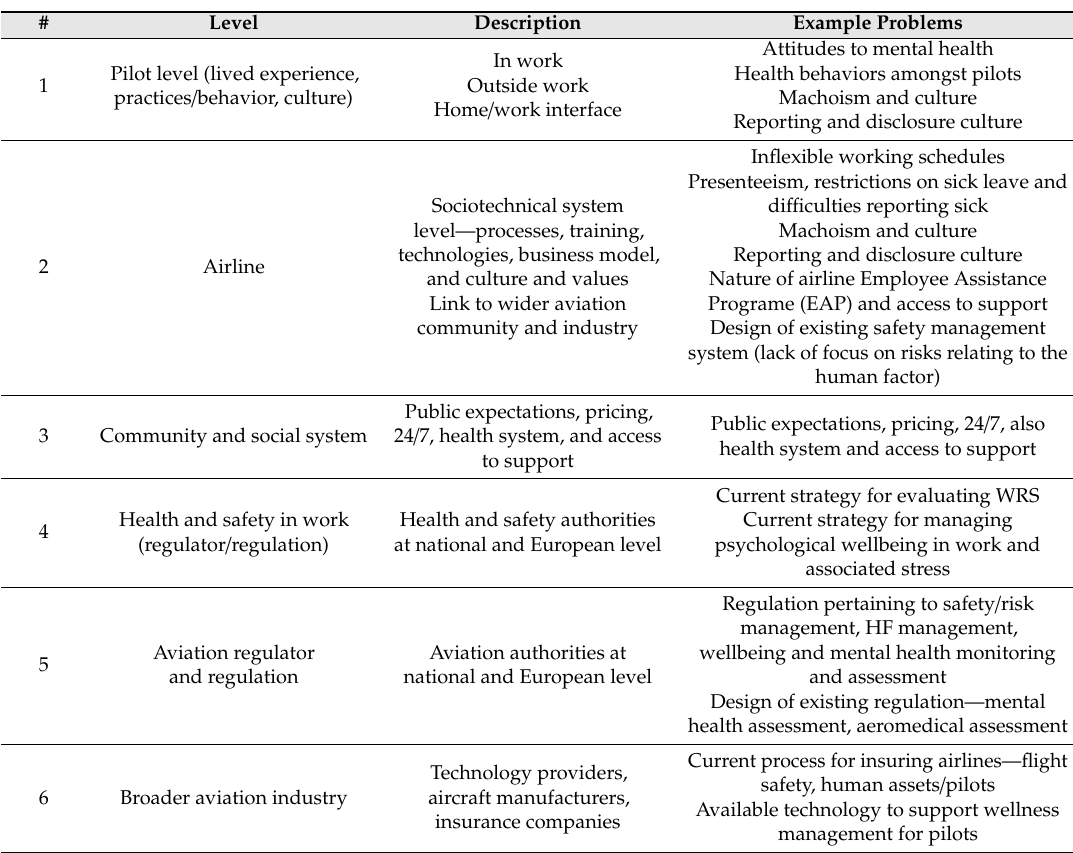
Table 2. Di ff erent levels and